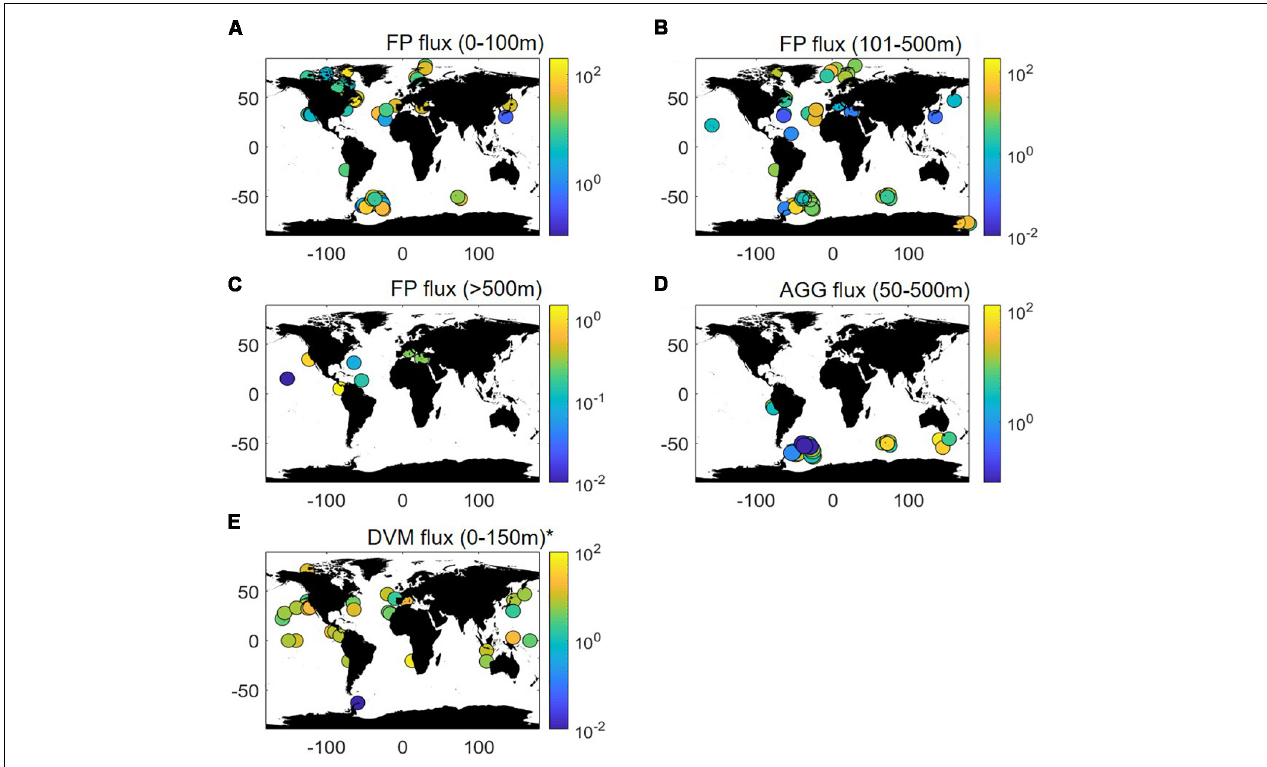
FIGURE 1 | Global distribution of downward flux of organic carbon (OC; units are mg of OC m − 2 d − 1 ) associated to various export pathways (see main text). Panel (A) represents the flux associated to fecal pellets (FP) collected between 0–100 m; (B) 101–500 m and (C) below 500 m. Panel (D) represents the flux of aggregates collected between 50–500 m. Panel (E) represents the flux associated to vertically migrating organisms. ∗ Replotted after Aumont et al. (2018). All references/sources are provided in the main text and in Supplementary Tables S1–S3